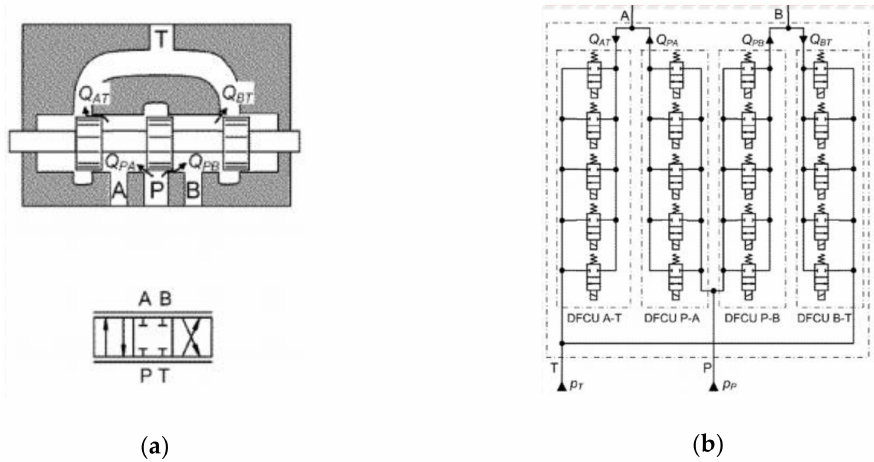
Figure 2. Two kinds of four-way valve: ( a ) traditional three-position four-way valve; ( b ) digital flow control unit (DFCU) four-way valve.